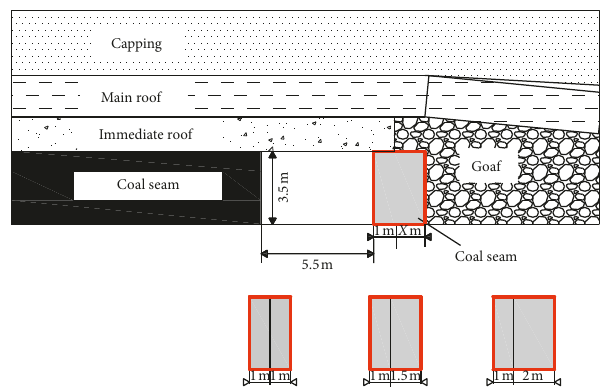
Figure 9: The layout diagram of the No. 18205 working face and